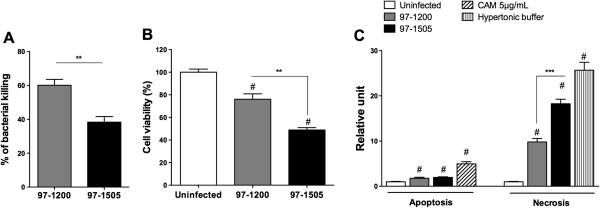
Intracellular killing of Mtb isolates 97-1200 or 97-1505 and cell death of infected alveolar macrophages. Alveolar macrophages were infected in vitro for 24 h with Mtb isolates 97-1200 or 97-1505 at MOI 5. (A) Bacterial killing was assessed by resazurin metabolisation and expressed as a percentage of phagocytised bacteria. (B) Cell viability assessed by resazurin metabolisation. Maximum viability (100%) is based on uninfected cells. (C) ELISA assay of apoptosis and necrosis 24 h post-infection of alveolar macrophages in vitro. Camptothecin 5 μg/mL (CAMP) was used as apoptosis-positive control and hypertonic buffer as necrosis-positive control. #P < 0.0001 for uninfected cells vs. infected cells (97-1505 or 97-1200); ***P < 0.0001; **P < 0.001 (one-way ANOVA). Data are representative of three (A, B) and two (C) independent experiments (error bars, s.e.m.).